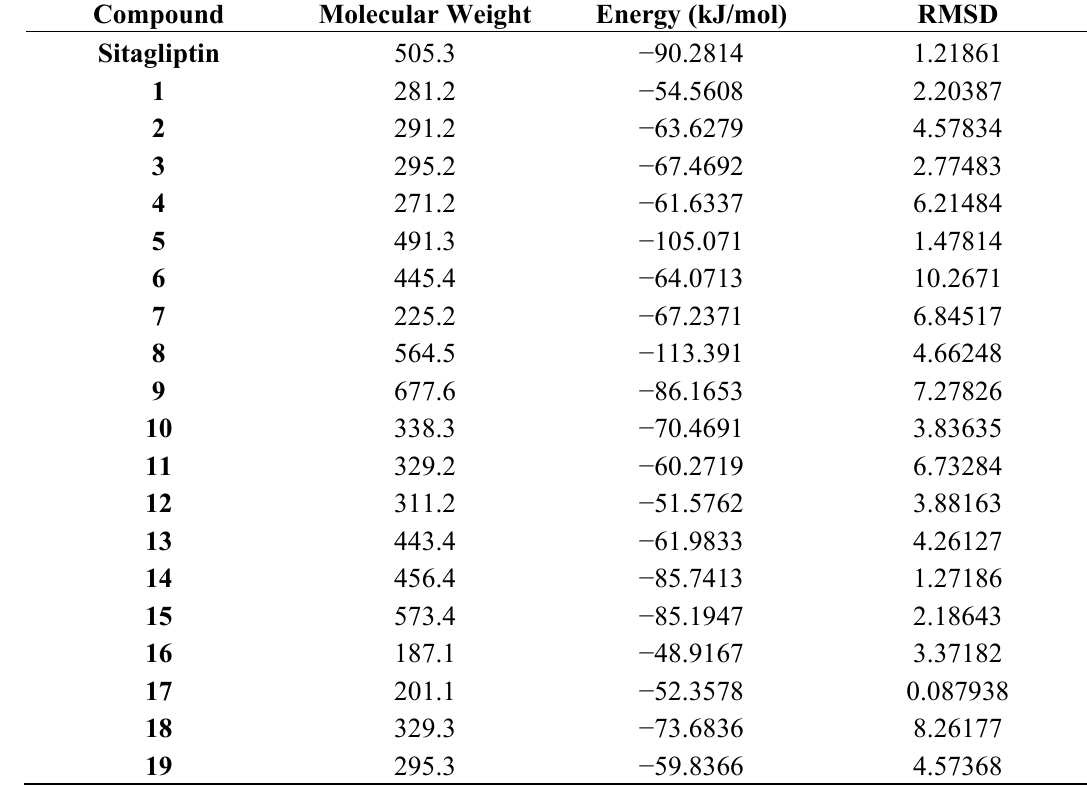
Table 2. Docking results of the proposed compounds and